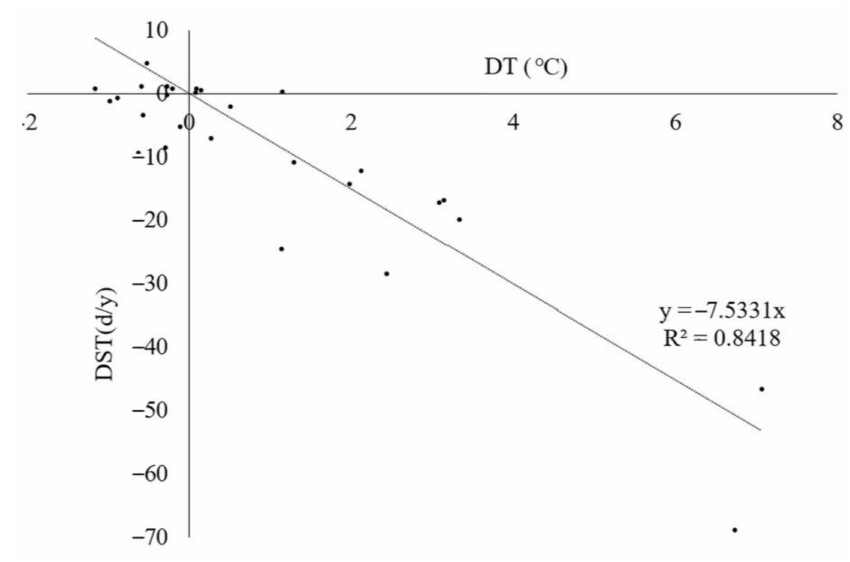
Figure 18. Correlation of DT and DST during snowfall